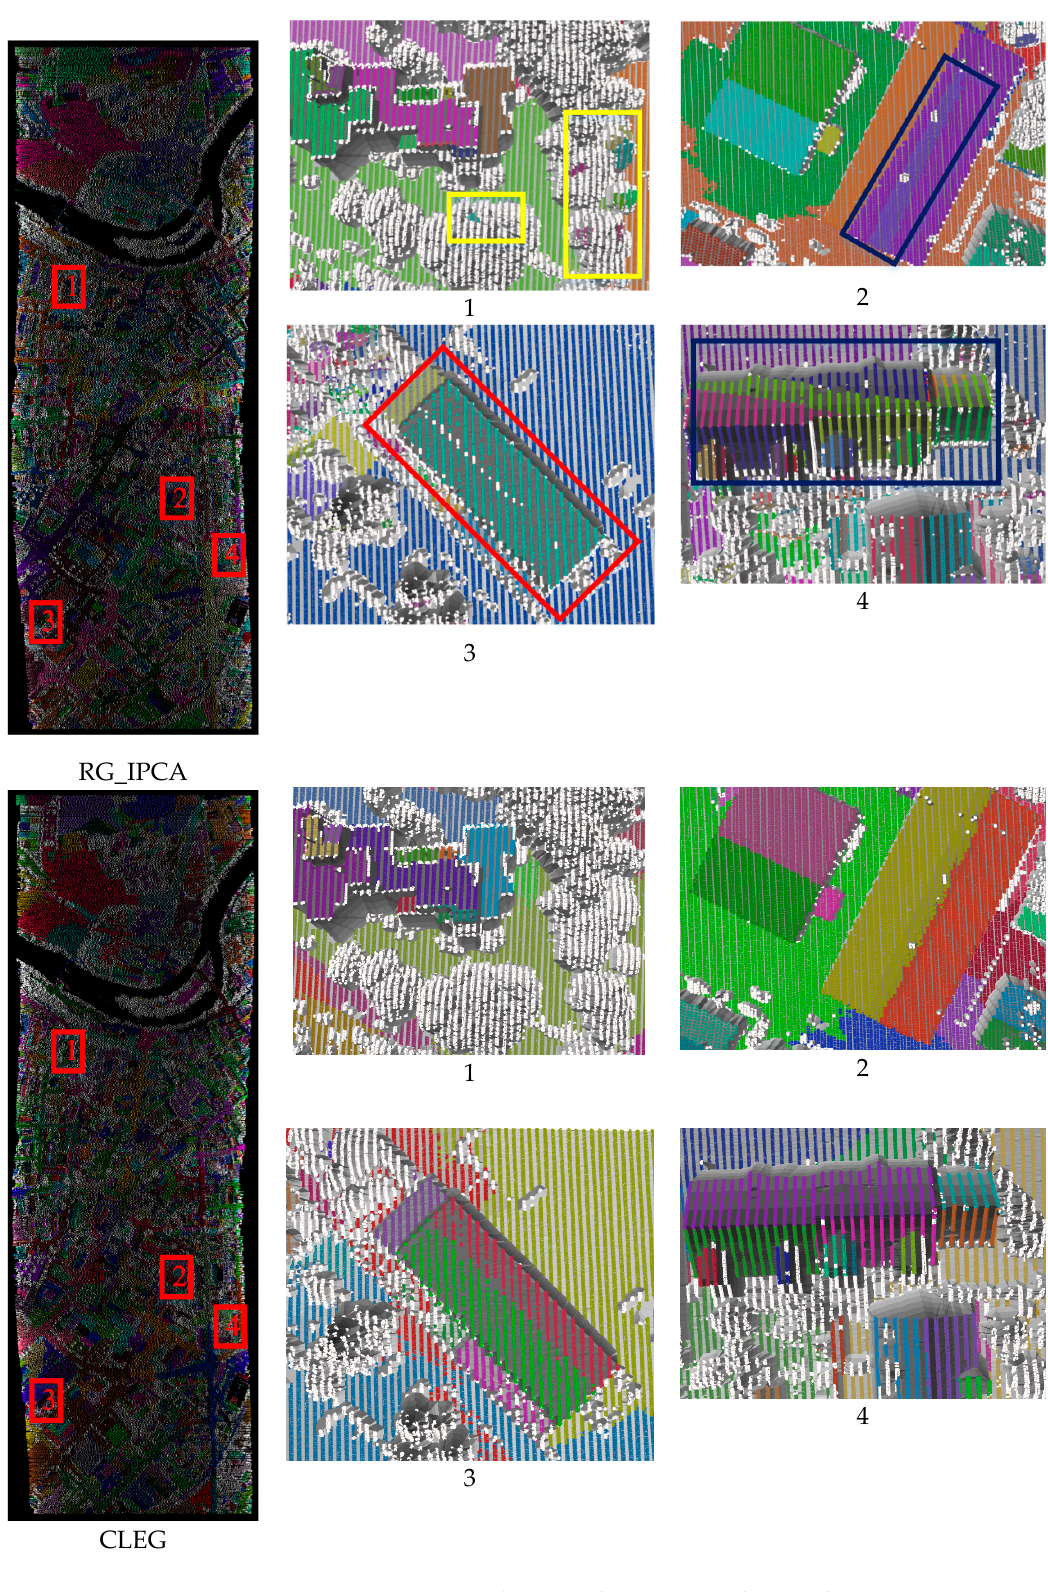
Figure 15. Segmentation results in Vaighingen using dataset (d).